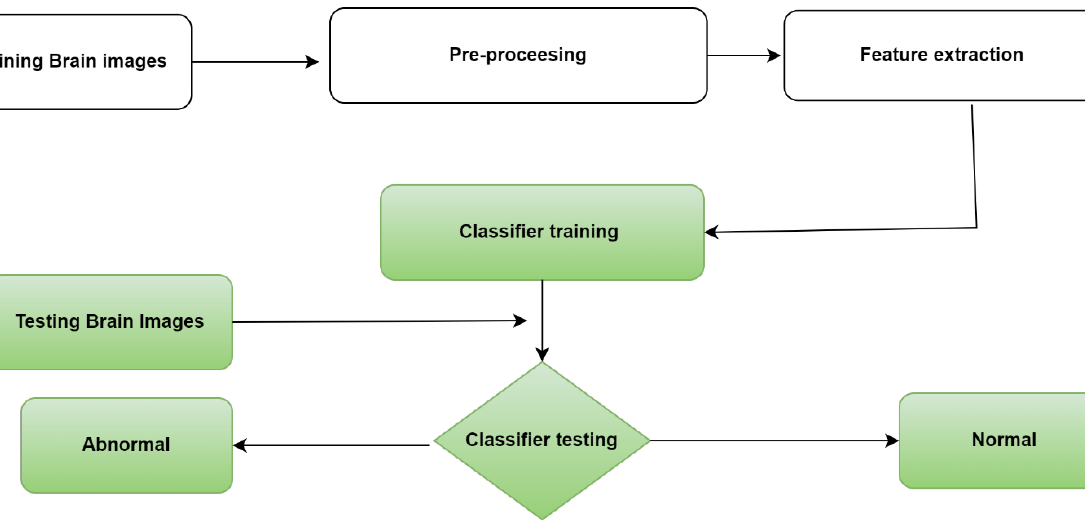
Figure 2. The flow diagram of the proposed work for BT classification.